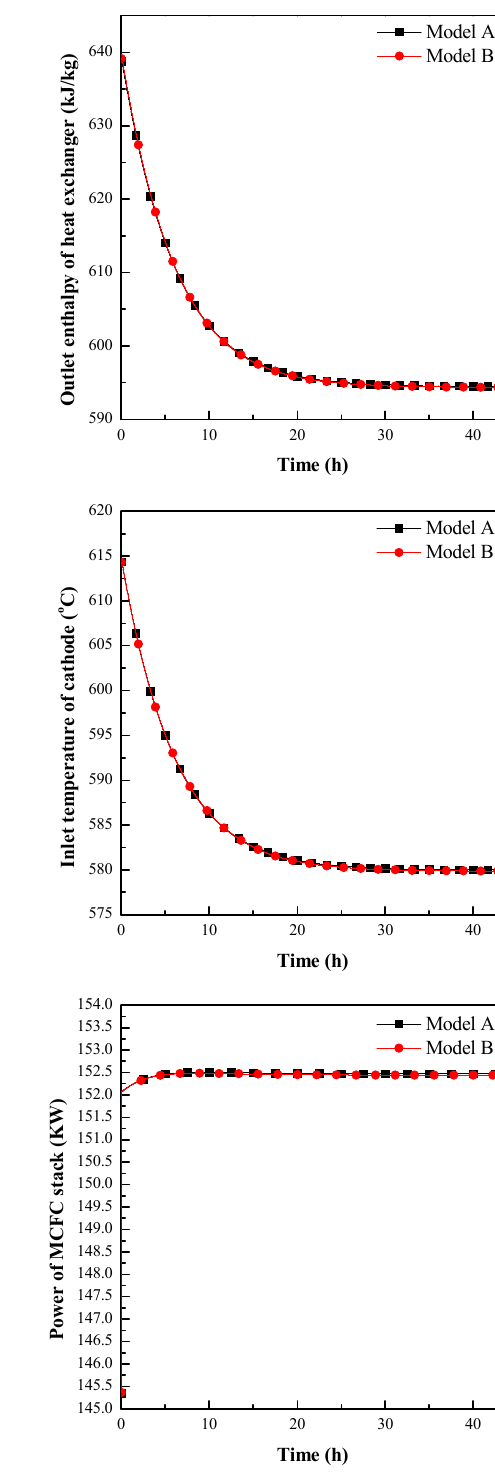
Figure 9. The step-up of the MCFC current density—comparison of the slow time scale transient response of the outlet temperature of the cathode, the outlet enthalpy of the heat exchanger, the power of the MGT, the inlet temperature of the cathode, the voltage of the fuel cell, and the power of the MCFC stack between the MCFC-MGT model and the MCFC-MGT model based on the Sim–Stim interface model.